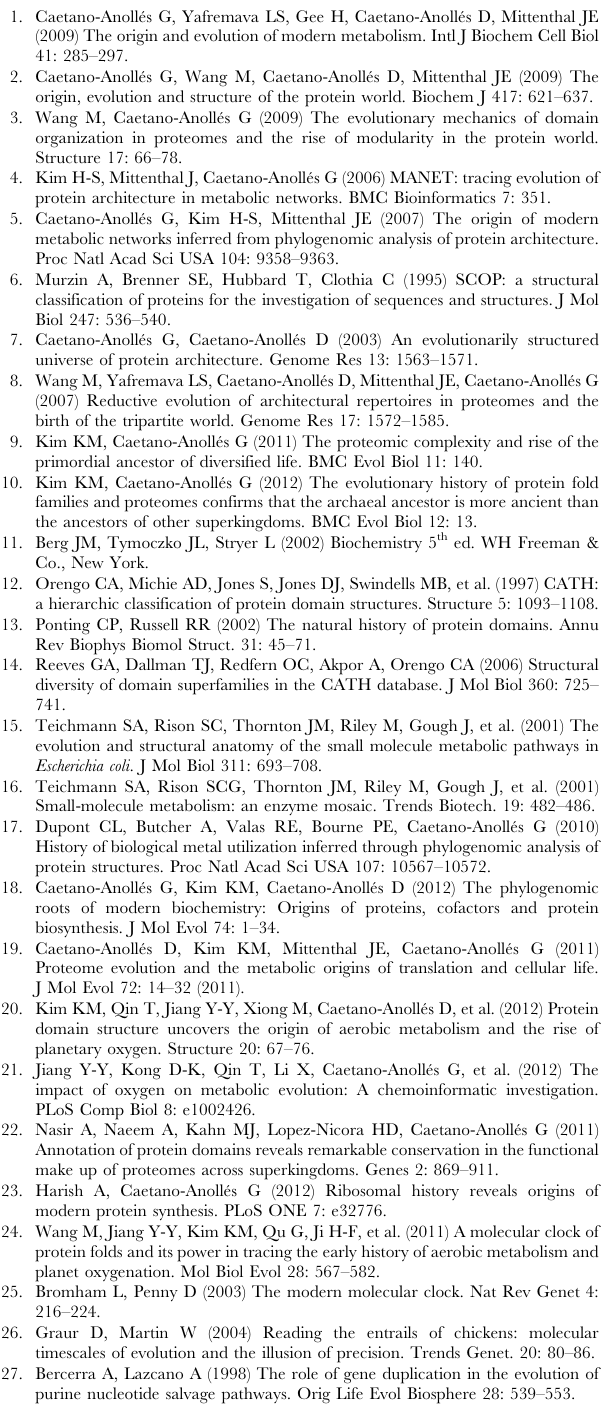
Table S1 Enzyme activities and associated FF assign- ments in purine metabolic